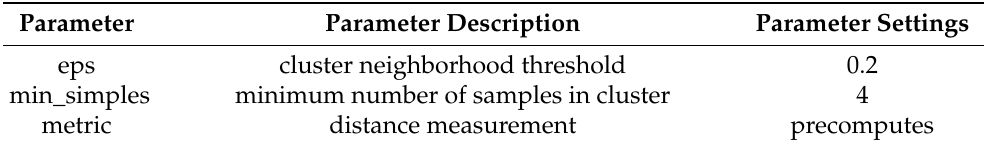
Table 4. DBSCAN clustering parameter